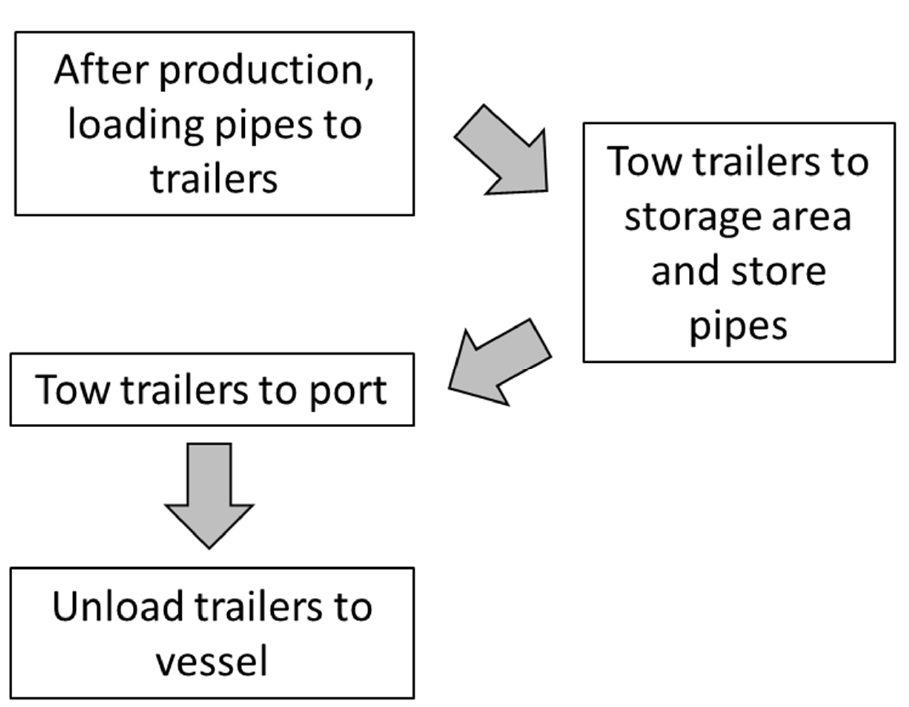
Figure 12. The logistic process with a container solution.